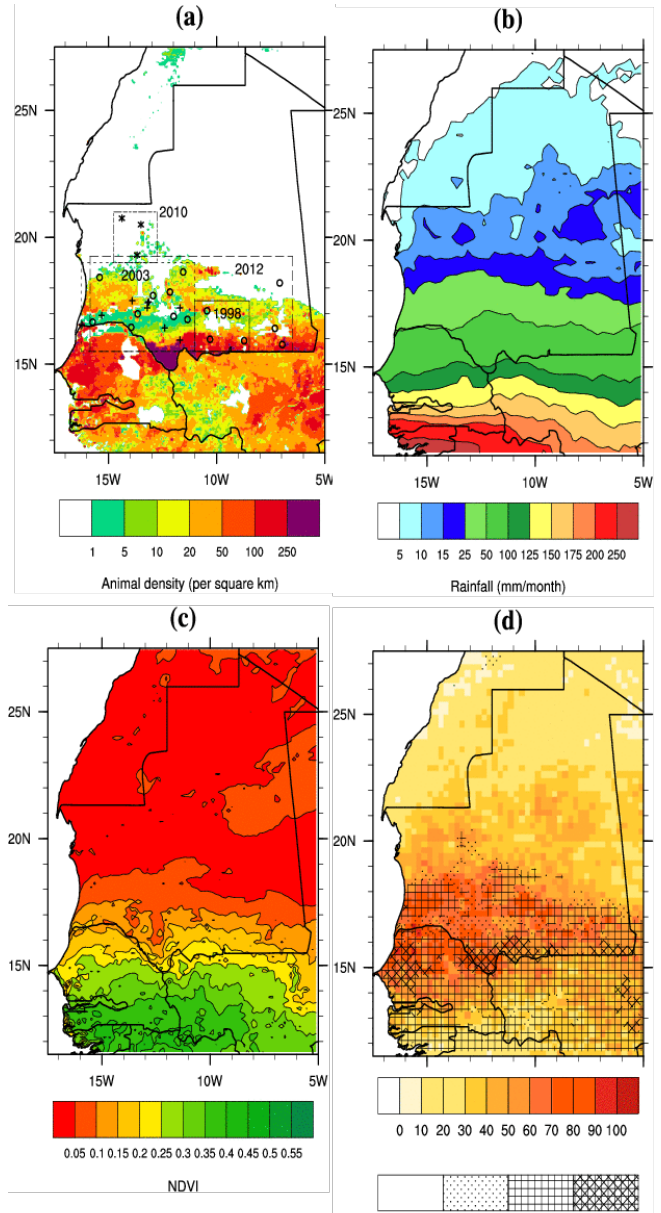
Figure 1. ( a ) Animal host density (sheep, goat and cattle) per km 2 based on FAO dataset. The boxes depict the regions affected and the crosses, stars and circles